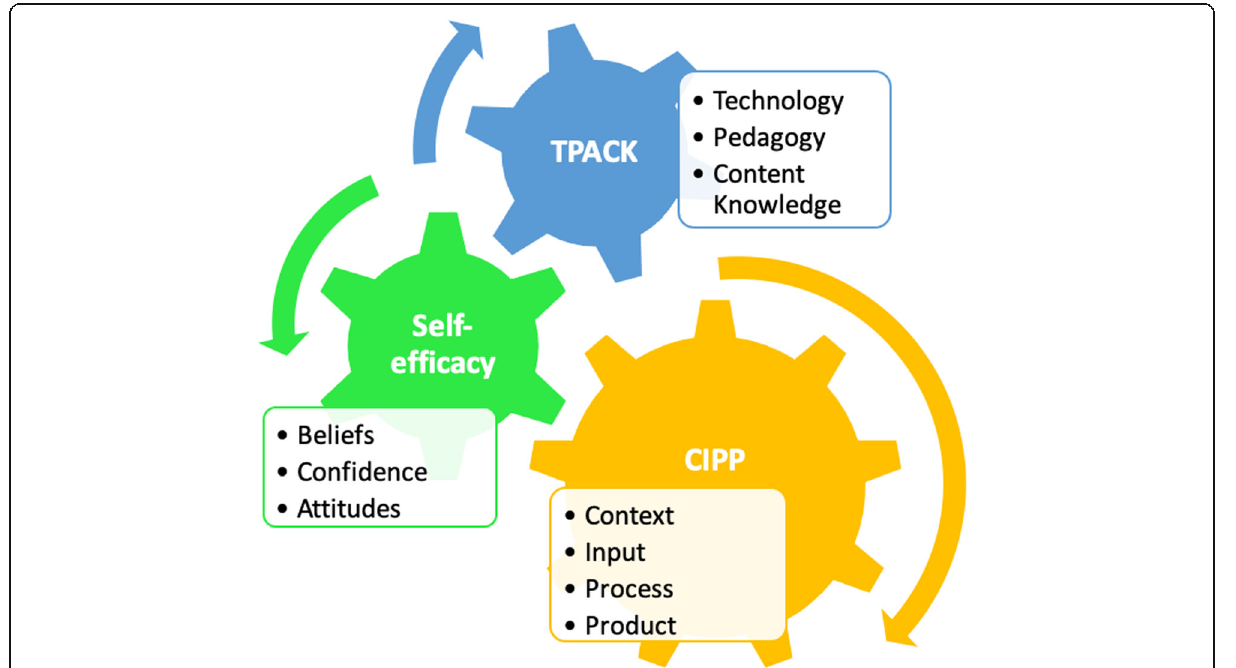
Fig. 1 The integration of self-efficacy, TPACK and the CIPP